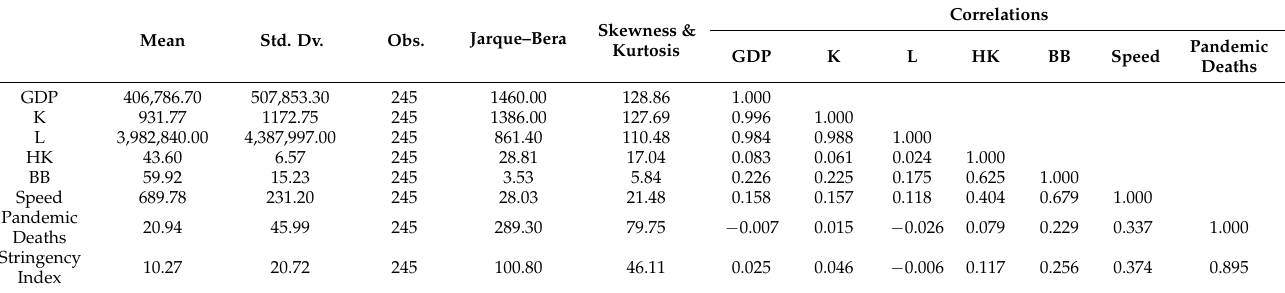
Table 3. Descriptive statistics and